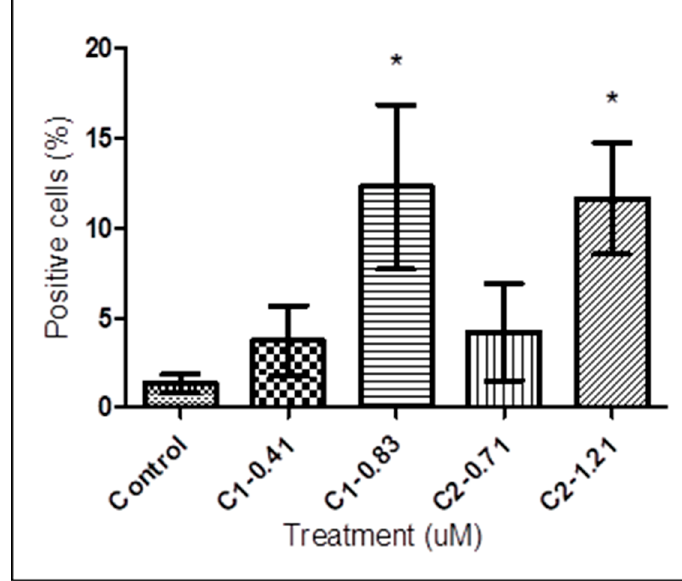
Figure 5. Quantitative analysis of caspase-like activity in T. b. rhodesiense . Treated and untreated trypanosomes were exposed to 1 at 0.41 and 0.83 μ M, and 2 at 0.71 and 1.21 μ M for 72 h, stained with caspase-3/7 green detection reagent (5 μ M) for 15 min and analyzed by flow cytometry. Trypanosomes treated with 0.41 and 0.83 μ M of 1, and 0.71 and 1.21 μ M of 2 resulted in an increment of caspase-3/7 positive cells from 1.35 ± 0.50% (control) to 3.70 ± 1.97%, 12.29 ± 4.59%, 4.20 ± 2.70%, and 11.64 ± 3.11%, respectively. Data presented as means ± SD from triplicates over three other independent experiments. The asterisks indicate significant differences between the treated and untreated groups calculated by one-way ANOVA with Tukey post-test (* p < 0.05). C, compound.